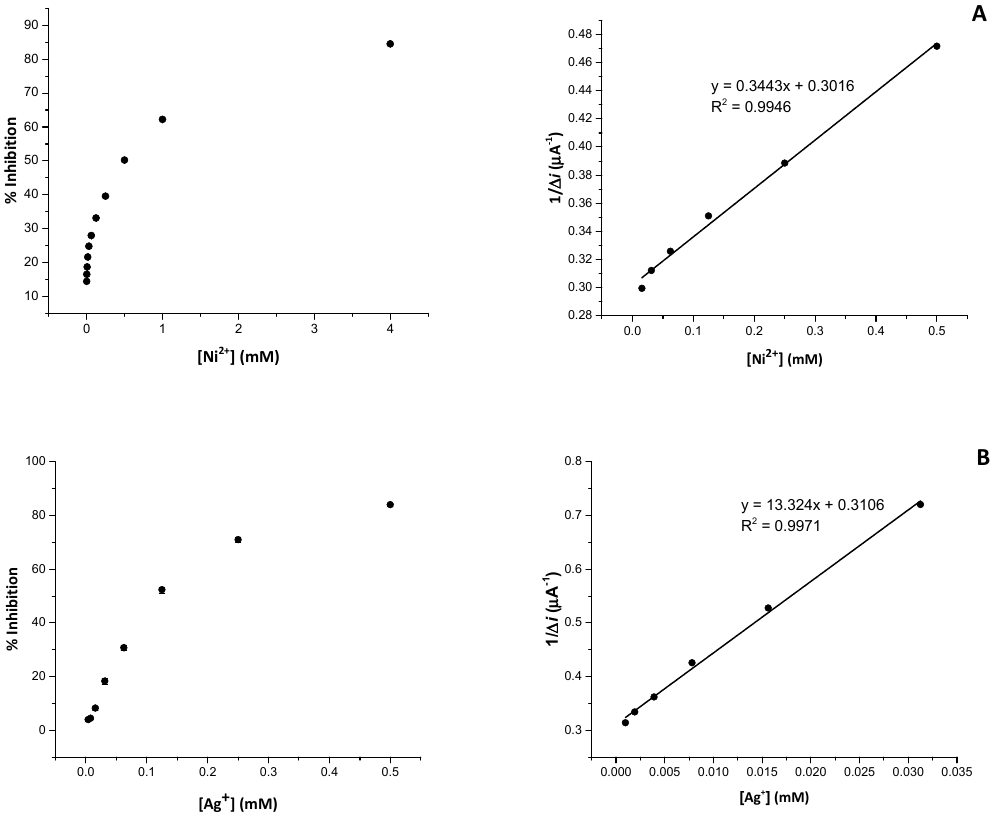
Figure 4. Inhibitive effects and Dixon plots for Pt/PPD/GOx biosensor after the injection of different concentration of Ni 2+ ( A ) and Ag + ( B ) in presence of 20 mM of glucose.